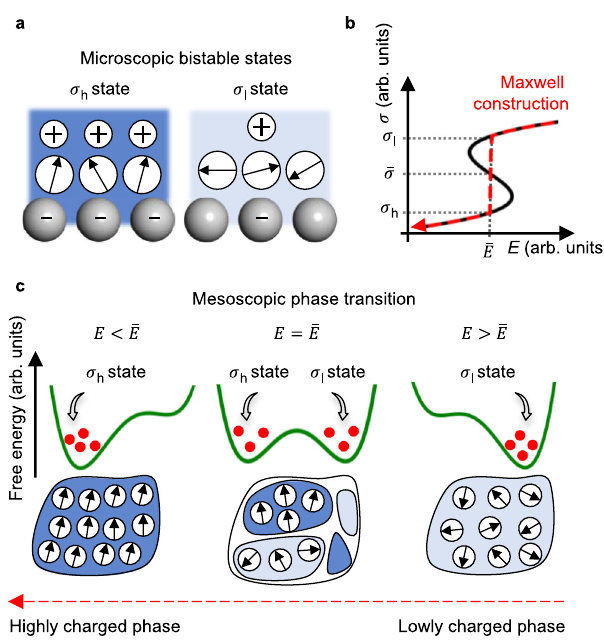
Fig. 3 EDL structural phase transition yields the cathodic hump. a Higher charged state with more-aligned water dipoles (that is, large | σ | and large ε σ eff ; h state) and lower charged state with less-aligned water dipoles (that is, small | σ | and small ε eff ; σ l state) are bistable at the same cathodic potential, E . b Phase transition between bistable states, which is modeled using Landau-type theory, yields the S-shaped region, at which the Maxwell tie-line is constructed. (cid:1) σ is de fi ned as ( σ h + σ l )/2, and phase transition occurs at E ¼ (cid:1) E . c At the mesoscopically large interface, σ l state is more populated when E > (cid:1) E , forming a lowly charged phase (right panels), and σ h state is more populated when E < (cid:1) E , forming a highly charged phase (left panels). Negative-potential sweep induces a phase transition from the lowly charged phase to the highly charged phase via a phase coexistence at E ¼ (cid:1) E